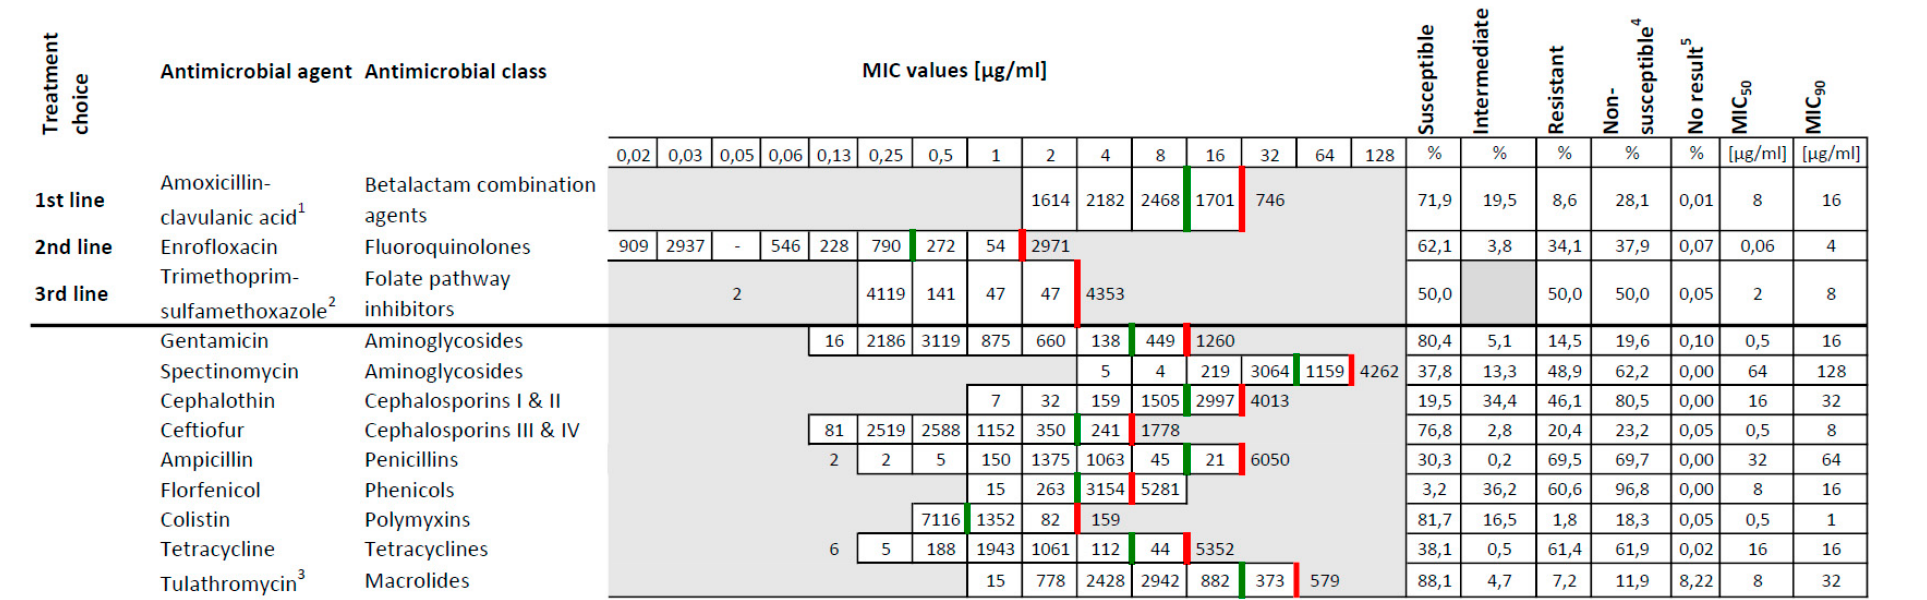
Figure 1. Minimum inhibitory concentration (MIC) distribution of 8713 E. coli isolates on 12 antimicrobial agents from 11 antimicrobial classes. The three first lines represent the clinically relevant substances, first to third treatment choices in buiatrics. The red line demarcates the breakpoint towards resistance, the green line a breakpoint towards intermediate. Regarding the two combination compounds, only the concentration of the former substance is presented; the ratio of amoxicillin:clavulanic acid is 2:1 (1), concentration ratio of trimethoprim:sulfamethoxazole is 1:19 (2). Tulathromycin has not been tested in the first quarter of 2015 (3). The summation of intermediate and resistant isolates was named non-susceptible (4). Some results were not evaluable (5).